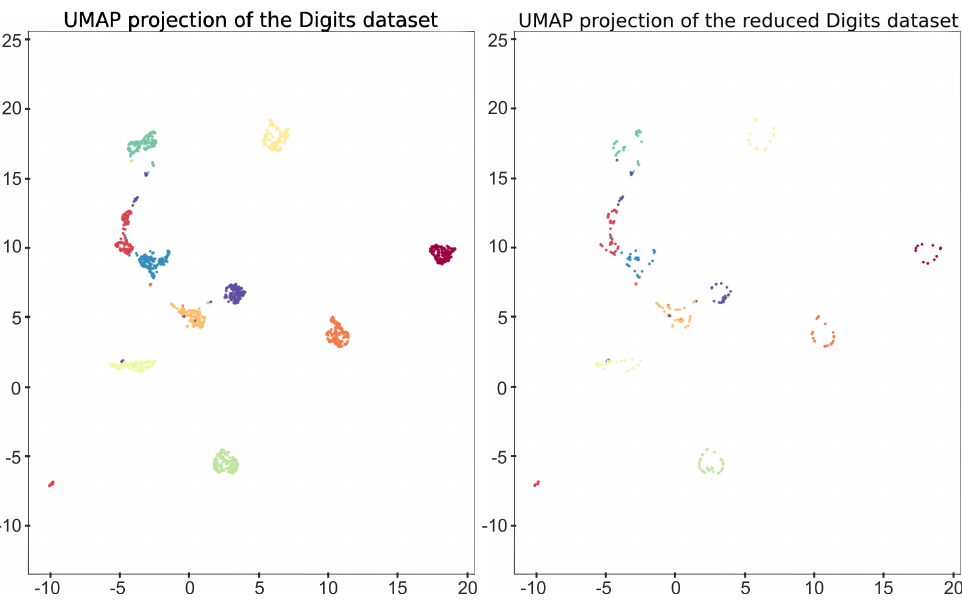
Figure 5. Visualization of the UMAP 2D representation of the original data set used ( left ), and the simplified data set obtained ( right